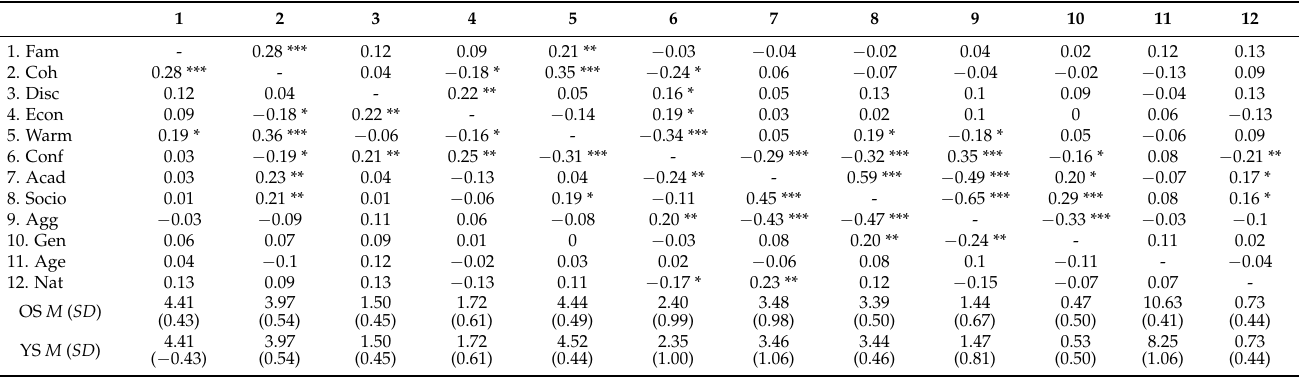
Table 1. Bivariate Correlations, Means, and Standard Deviations for Study